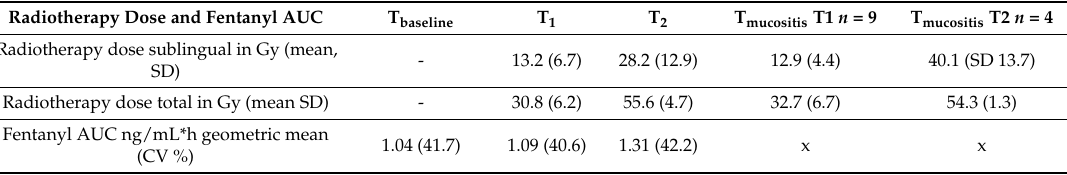
Table 2. Radiotherapy dose during the chemo- or